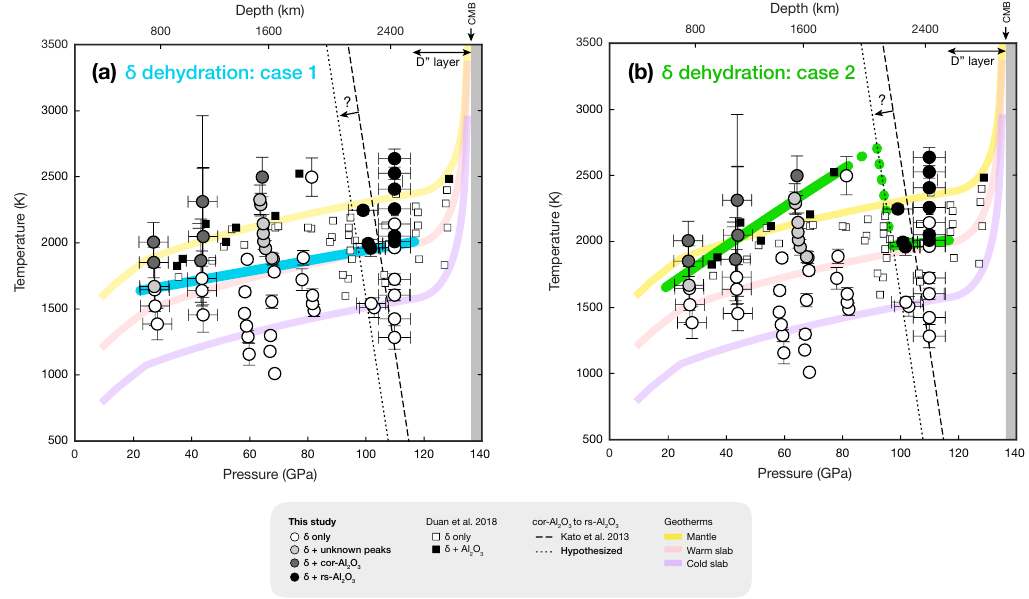
Figure 3. Pressure and temperature conditions of δ -AlOOH dehydration from XRD experiments. The solid circles are our data points (white: δ -AlOOH only, dark gray: cor-Al 2 O 3 in δ -AlOOH, black: rs-Al 2 O 3 in δ -AlOOH with Fe hydroxides, light gray: appearance of unknown peaks near dehydration). Our proposed dehydration lines are shown by the colored lines for ( a ) case 1 and ( b ) case 2 (see the text for detail). Above 100 GPa, a single dehydration line is proposed. The phase boundary between cor-Al 2 O 3 and rs-Al 2 O 3 reported by Kato et al. [13] is shown as a thin black dashed line. The dotted line shows hypothesized boundary for the phase transition to match with our interpretation. The open and the solid black squares are observations of δ -AlOOH and δ -AlOOH + Al 2 O 3 , respectively, by Duan et al. [10]. The cold and warm slab temperature profiles, as well as the mantle geotherm [27], are also shown by different thick colored